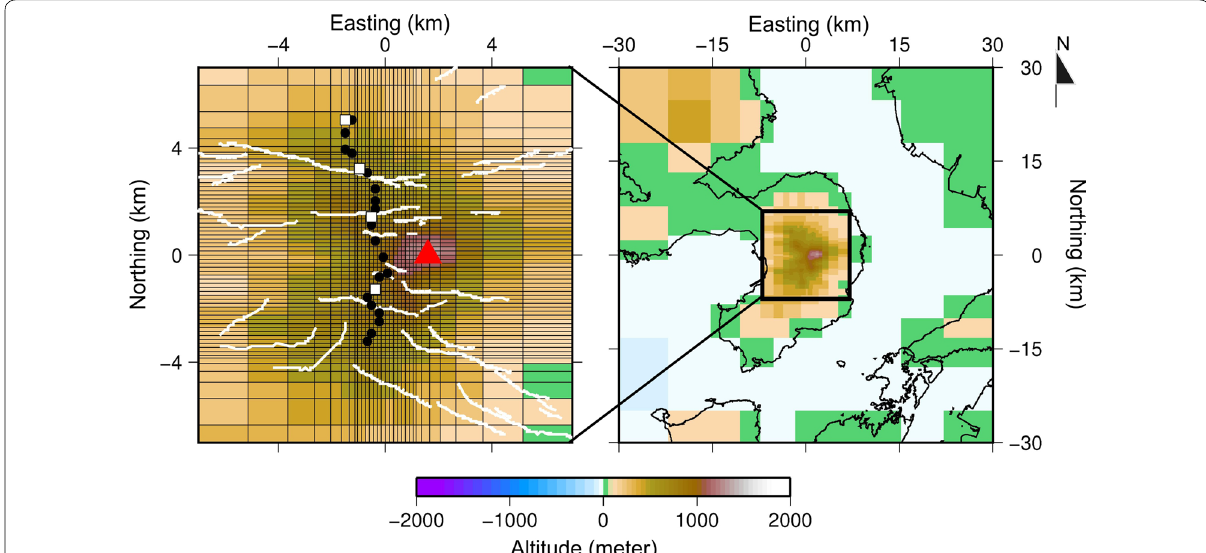
Fig. 3 Mesh configuration used in the inversion and its relative position to Shimabara Peninsula. a Mesh used in the inversion. The black circles and white squares indicate telluric sites and MT sites used in the inversion, respectively. Red triangle denotes Unzen’s highest peak, the Heisei Shinzan lava dome. White lines indicate faults in the survey region. b The black square over Shimabara Peninsula indicates the area shown in